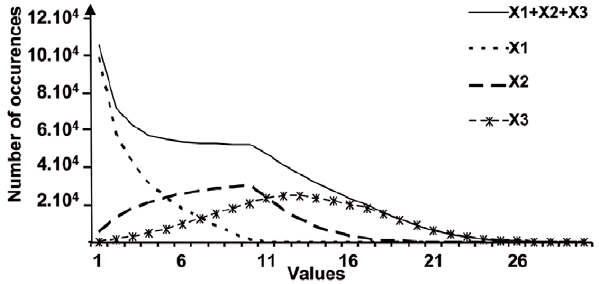
Figure 8. Successive rearrangements and building of the combinatorial repertoire shape. Three successive draws of random integers were done successively, the first one giving an integer x1 between 0 and 10 following a Poissonian law. The second and the third ones follow a Gaussian law, the second giving an integer x2 between x1 and x1 + 10, and the third giving an integer x3 between x2 and x2 + 10, and that 300 000 times. The first, second and third curves were added to build the sum